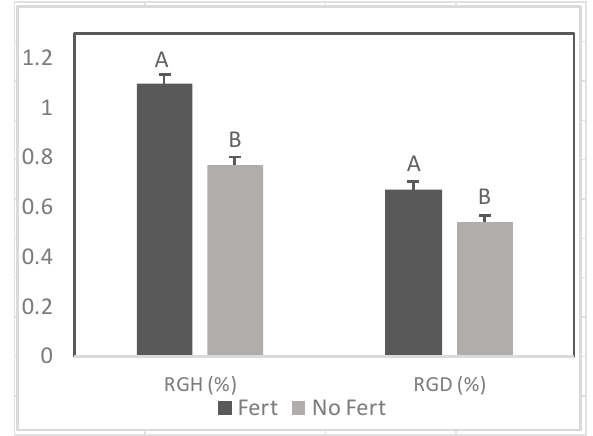
Figure 3. Effect of fertilizer (Fert) on relative growth rate of height (RGH) and diameter (RGD) among Senegalia senegal seedlings. Different letters on bars mean significant differences between fertilized (Fert) and no fertilized (No Fert) at p < 0.05.